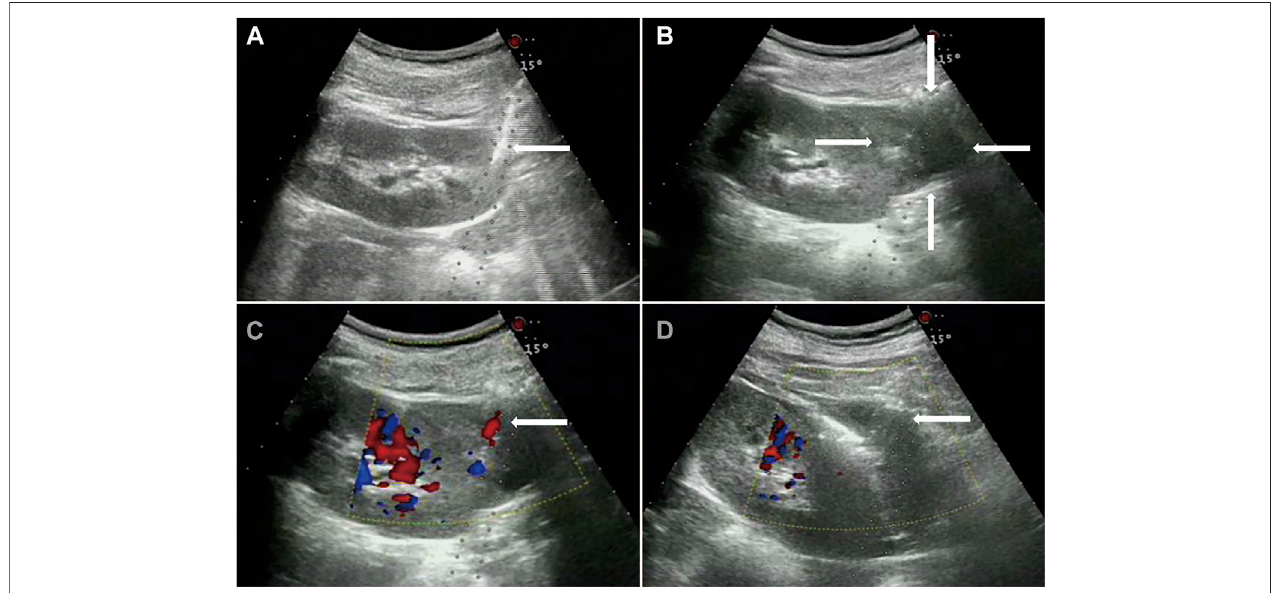
FIGURE 1 | Glomerular disease in a 63-year-old woman. (A) , Core needle biopsy of renal parenchyma. (B) , Hematomas can be seen around the kidney. (C) , 30 min after the biopsy, active bleeding within the biopsy track indicated by color Doppler. (D) , 22-gauge PAN needle was punctured to the bleeding point of renal capsule under the guidance of color Doppler ultrasound, and after 4 ml lauromacrogol injection, the color Doppler ultrasound showed that the blood fl ow signal disappeared.